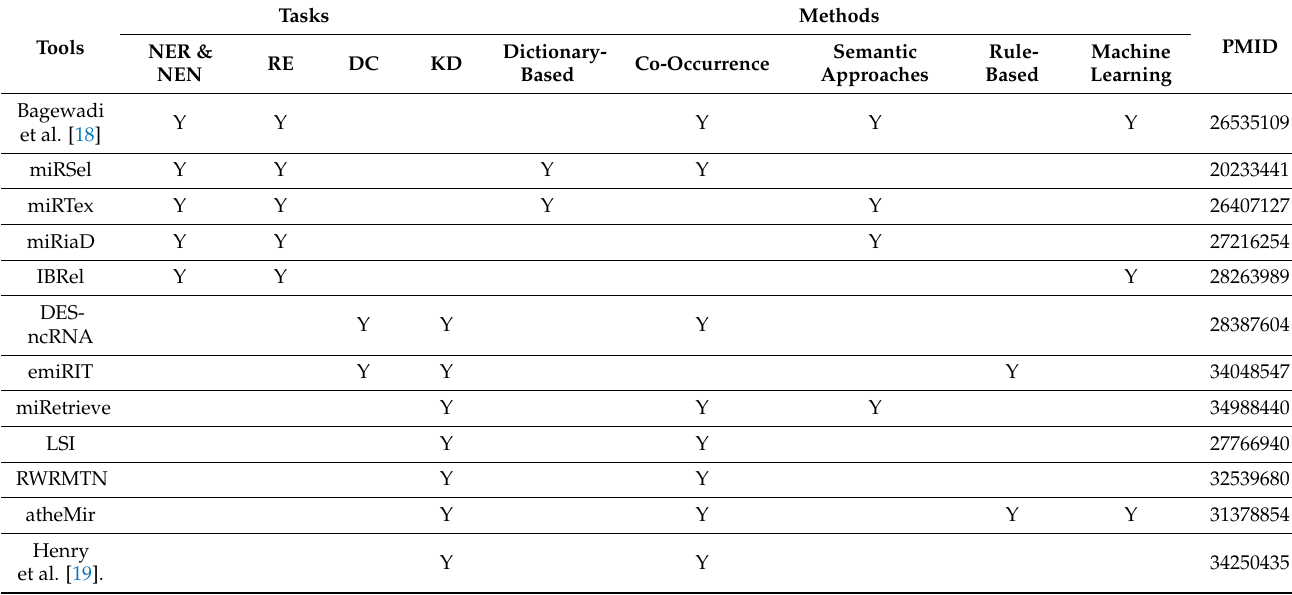
Table 1. Selected text-mining systems and tools for ncRNA